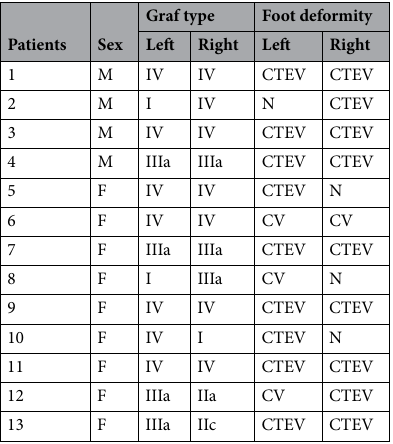
Table 4. Detailed description of the foot deformity. M male, F female, N normal, CTEV congenital talipes equinovarus, CV calcaneous